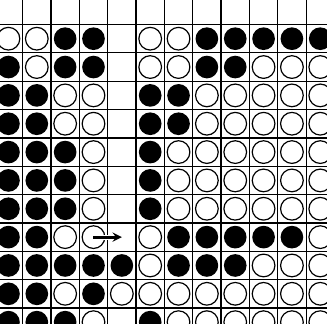
Figure 47. The center left WHITE moves.